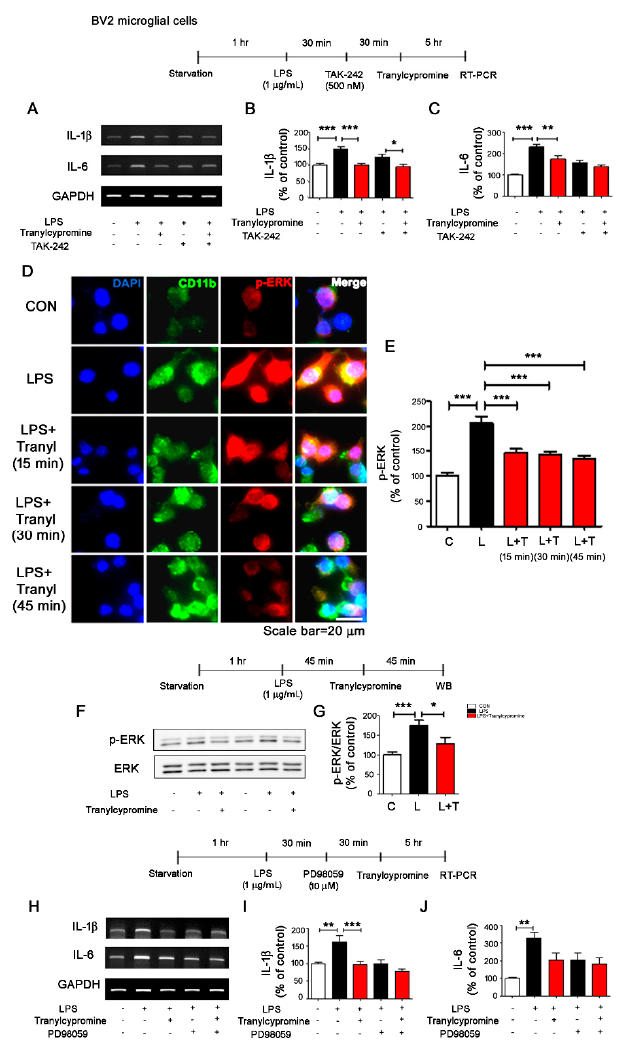
Figure 2. Tranylcypromine inhibits TLR4 / ERK signaling in BV2 microglial cells. ( A – C ) BV2 microglial cells were pretreated with LPS (1 µ g / mL) or PBS for 30 min, treated with TAK-242 (TLR4 inhibitor, 500 nM) for 30 min, and treated with tranylcypromine (5 µ M) or PBS for 5 h. IL-1 β or IL-6 mRNA levels were then measured using RT-PCR ( n = 11 / group). ( D – E ) BV2 microglial cells were pretreated with LPS (1 µ g / mL) or PBS for 45 min and treated with tranylcypromine (5 µ M) or vehicle (1% DMSO) for 15, 30, or 45 min, and immunocytochemistry was conducted (CON, n = 211; LPS, n = 241; LPS + tranylcypromine (15 min), n = 333; LPS + tranylcypromine (30 min), n = 230; LPS + tranylcypromine (45 min), n = 314). ( F , G ) BV2 microglial cells were pretreated with LPS (1 µ g / mL) or PBS for 45 min and treated with tranylcypromine (5 µ M) or vehicle (1% DMSO) for 45 min, and Western blotting was performed with anti-p-ERK and anti-ERK antibodies ( n = 14 / group). ( H – J ) BV2 microglial cells were pretreated with LPS (1 µ g / mL) or PBS for 30 min, treated with ERK inhibitor (PD98059, 10 µ M) or vehicle (1% DMSO) for 30 min, and treated with tranylcypromine (5 µ M) or vehicle (1% DMSO) for 5 h. IL-1 β or IL-6 mRNA levels were then measured using RT-PCR ( n = 10 / group). * p < 0.05, ** p < 0.01, *** p < 0.001. CON and C, control; L, LPS; L + T, LPS +